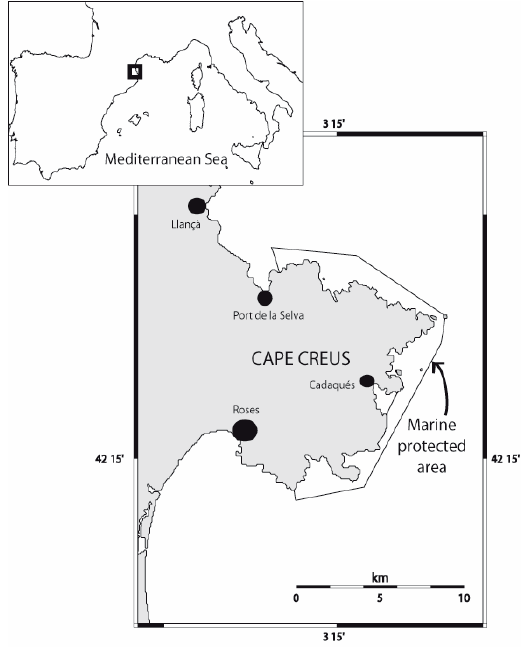
Figure 1. The marine protected area of Cap de Creus.